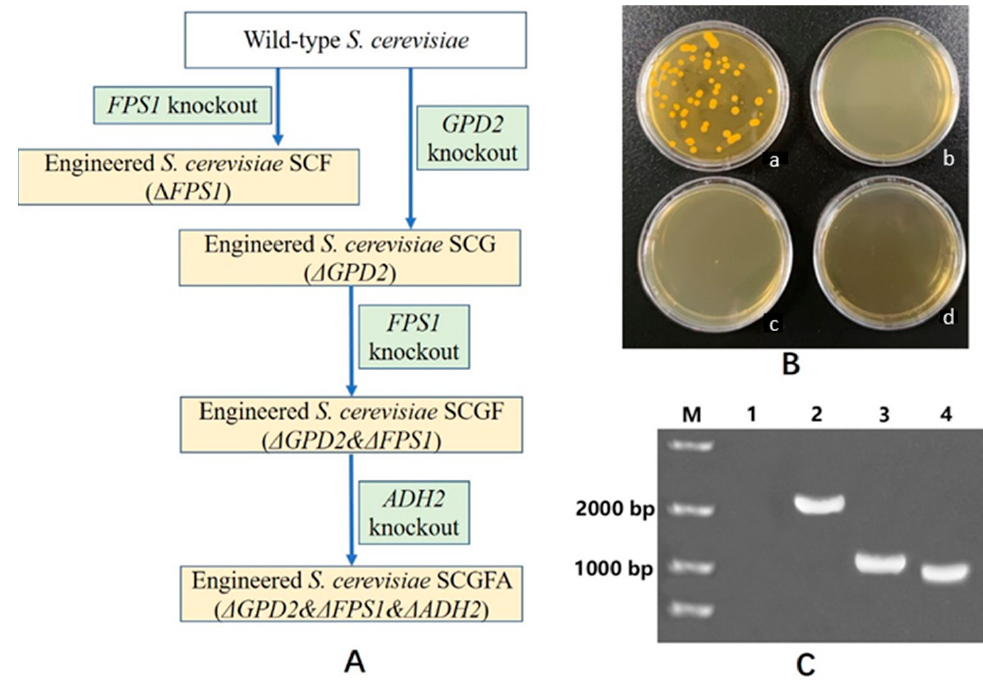
Figure 3. S. cerevisiae transformation pathways, screening, and identification. All solid YPD agar plates contained 80 µ g/mL nourseothricin and 300 µ g/mL hygromycin B. ( A ) Construction pathways of four S. cerevisiae mutants; ( B ) Screening of SCGFA GPD2 ∆ FPS1 ∆ ADH2 ∆ transformant. ( a ) transformant screening; ( b ) the control without addition of insert DNA; ( c ) the control without addition of gRNA-ADH2 vector; ( d ) the control using the direct culture of SCGF GPD2 ∆ FPS1 ∆ without transformation. ( C ) PCR amplification for SCGFA GPD2 ∆ FPS1 ∆ ADH2 ∆ identification. M represented marker; lanes 2, 3, and 4 indicated DNA amplification bands from TV-AFB1D (2091 bp), DPE (910 bp), and OM-PLA1 (879 bp), respectively.